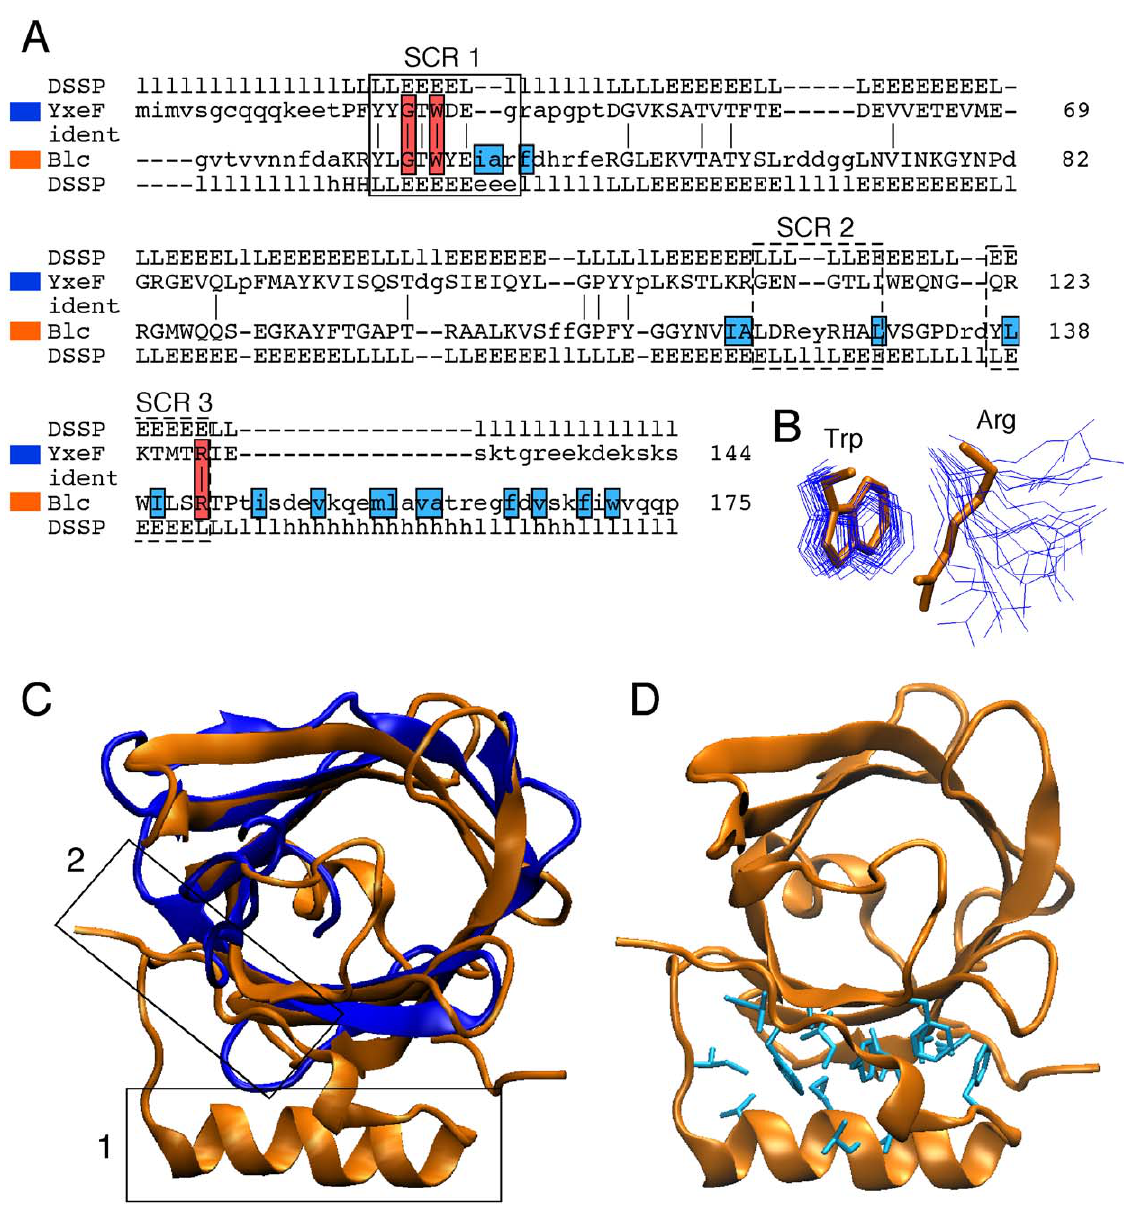
Figure 5. Comparison of YxeF NMR structure (PDB ID 2JOZ, coded in blue) and Blc X-ray crystal structure (PDB ID 3MBT, orange). (A) Structure-based sequence alignment between YxeF and Blc obtained with the program DALI [16]. The three structurally conserved regions (SCR1-3) typically found in lipocalins (see text) are boxed (continuous line for SCR1, which appears to be conserved in YxeF; dashed line for SCR2 and SCR3). Conserved residues being part of the calycin signature motif resulting in an interaction between Gly 36-X-Trp 38 in SCR1 and Arg 128 in SCR3 (see text) are highlighted using red boxes. Residues being part of the second hydrophobic core of Blc [see also (D] are highlighted using cyan boxes. (B) Superposition of the Trp and Arg residues being part of the calycin Gly-X-Trp and Arg motif in Blc (licorice representation, orange) and YxeF (line representation, all NMR conformers, blue). The superposition is obtained after superposition of the X-ray structure of Blc with each conformer of the NMR solution structure of YxeF (residues 32–132). (C) Structural superposition generated by the program DALI viewed from the open end of the b - barrels (for YxeF residues 32–132 were considered). In Blc, box 1 identifies the C-terminally located a -helix and box 2 the C-terminal b -strand, which are packed against the outside of the b -barrel and thereby form a second hydrophobic core (see D). (D) Ribbon drawing of the Blc structure with licorice representation of hydrophobic residues (in cyan) located in the C-terminal a -helix and on the outside of the b -barrel forming a second hydrophobic core [see also (C)]. doi:10.1371/journal.pone.0037404.g005 alignment top hits (Table 2; note that in these comparisons we minor structural difference between the YxeF and Blc b -barrels, consider conformer 1 of the ensemble representing the YxeF possibly reflecting different ligand specificities, relates to b -strand solution structure 2JOZ). The corresponding values calculated for A at the base of the V -type loop. This strand is shorter in YxeF avidin, which contains a b -barrel of evidently different shape where it creates a small V-shaped aperture on the side of the b - (Figure 6), are also provided in Table 2 for comparison. The only barrel (Figure 6).